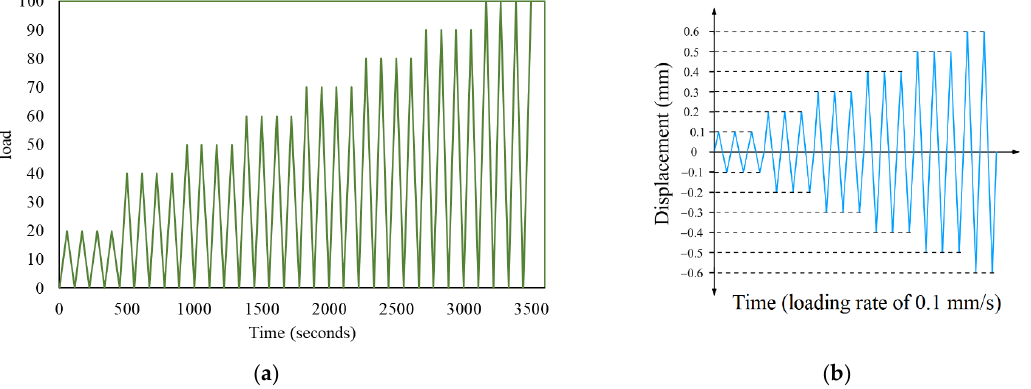
Figure 2. Cyclic loading used to study the bond performance: ( a ) Cyclic Load-controlled Loading Pattern by Aly et al. [46]; ( b ) Cyclic Displacement-controlled Loading Pattern by Xue et al. [47].